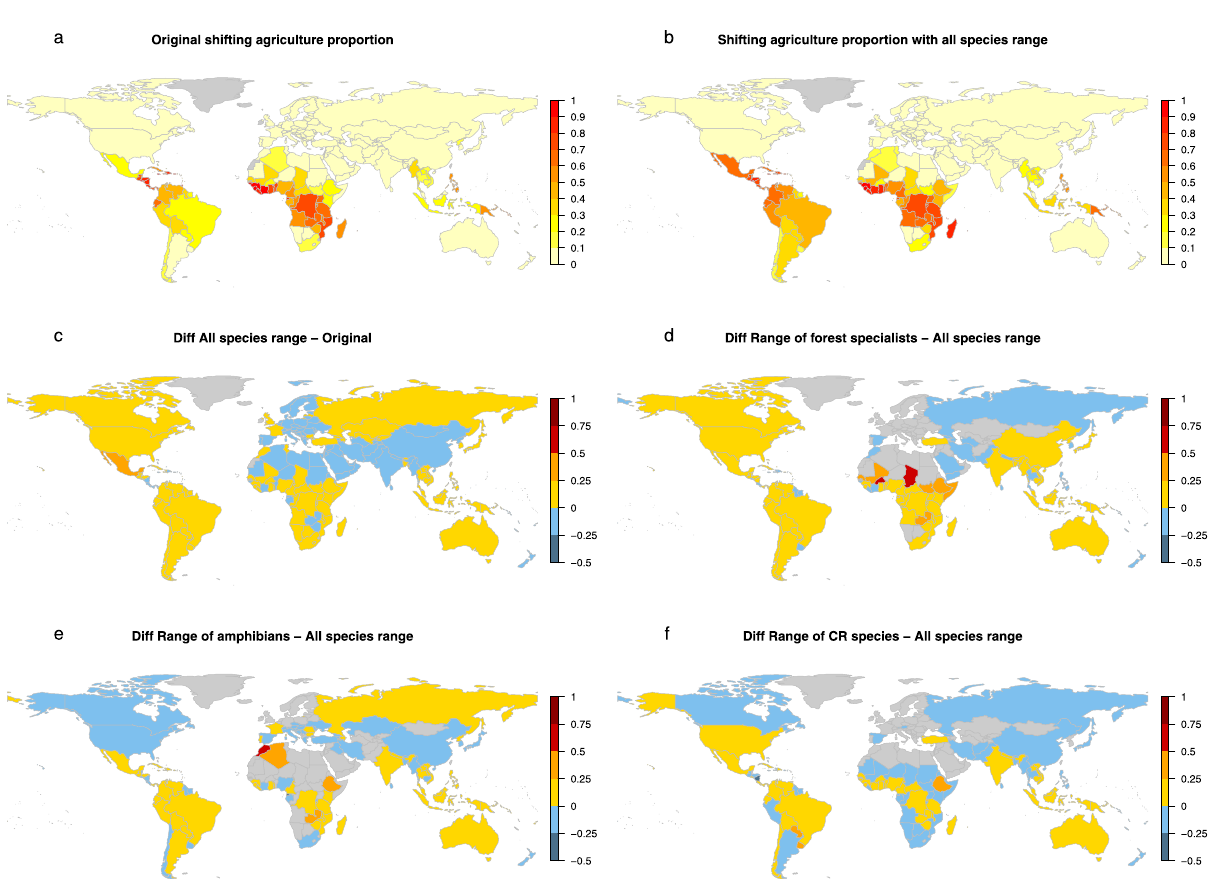
Fig. 3 Global pattern of shifting agriculture proportions at the national level. a Original shifting agriculture proportion calculated on a 10-km × 10-km-grid forest disturbance driver map 2 . b Shifting agriculture proportion within all species ranges (see Methods for details). c Difference between proportions ( b minus a ). d Difference between proportions with forest habitat specialist range and all species. e Difference between proportions with amphibian species range and all species. (f) Difference between proportions with critically endangered (CR) species range and all species range. Gray: no available